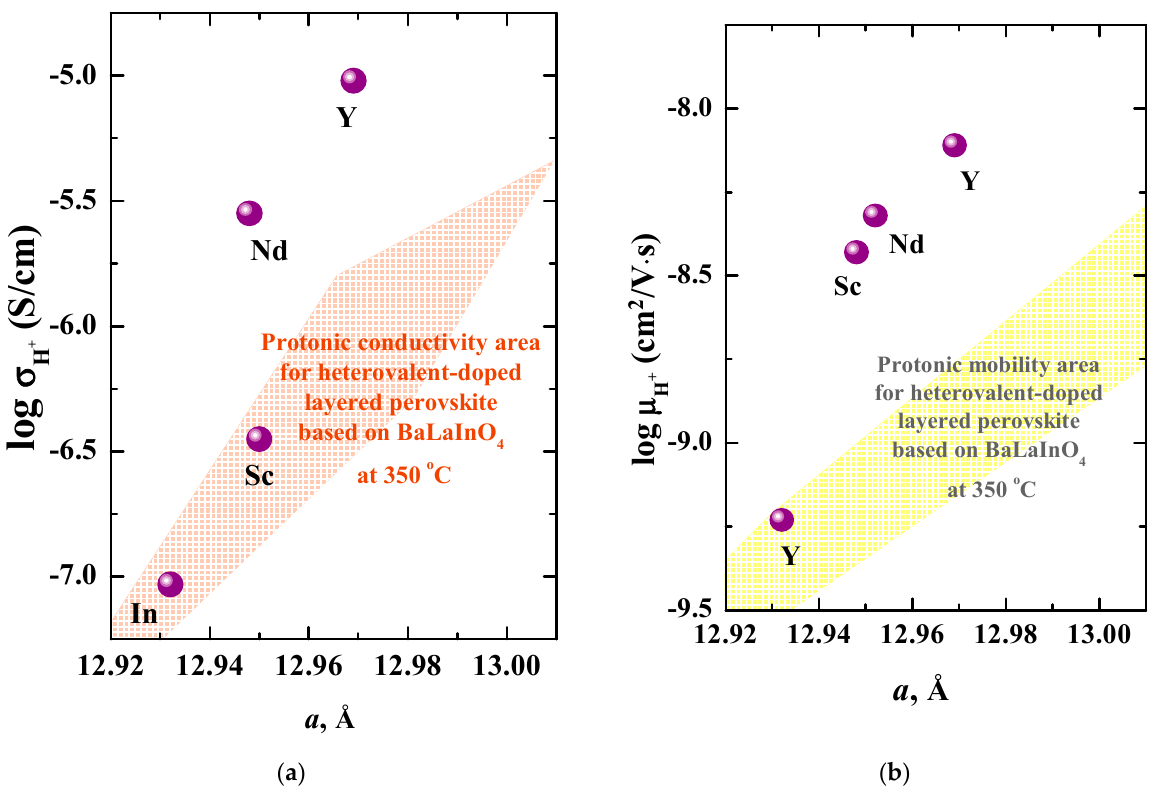
Figure 10. Dependencies of protonic conductivity ( a ) and mobility ( b ) from a lattice parameter for the compositions BaLa 0.9 Nd 0.1 InO 4 (Nd), BaLaIn 0.9 Sc 0.1 O 4 (Sc) [54], BaLaIn 0.9 Y 0.1 O 4 (Y) [55], BaLaInO 4 (In) [49] at 350 °C. The orange and yellow areas are defined as the protonic conductivity and mobility areas correspondingly for the acceptor- and donor-doped compositions based on BaLaInO 4 with 0.1 mol dopant content [62].